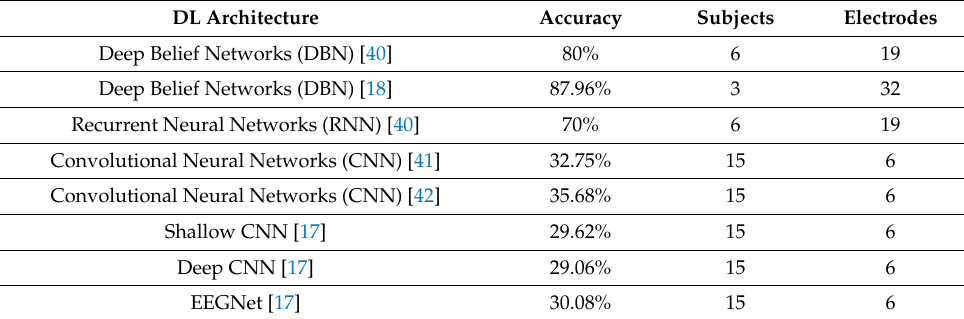
Table 2. Classifiers with DL used for imagined vowel recognition (/a/,/e/,/i/,/o/,/u/). DL Architecture